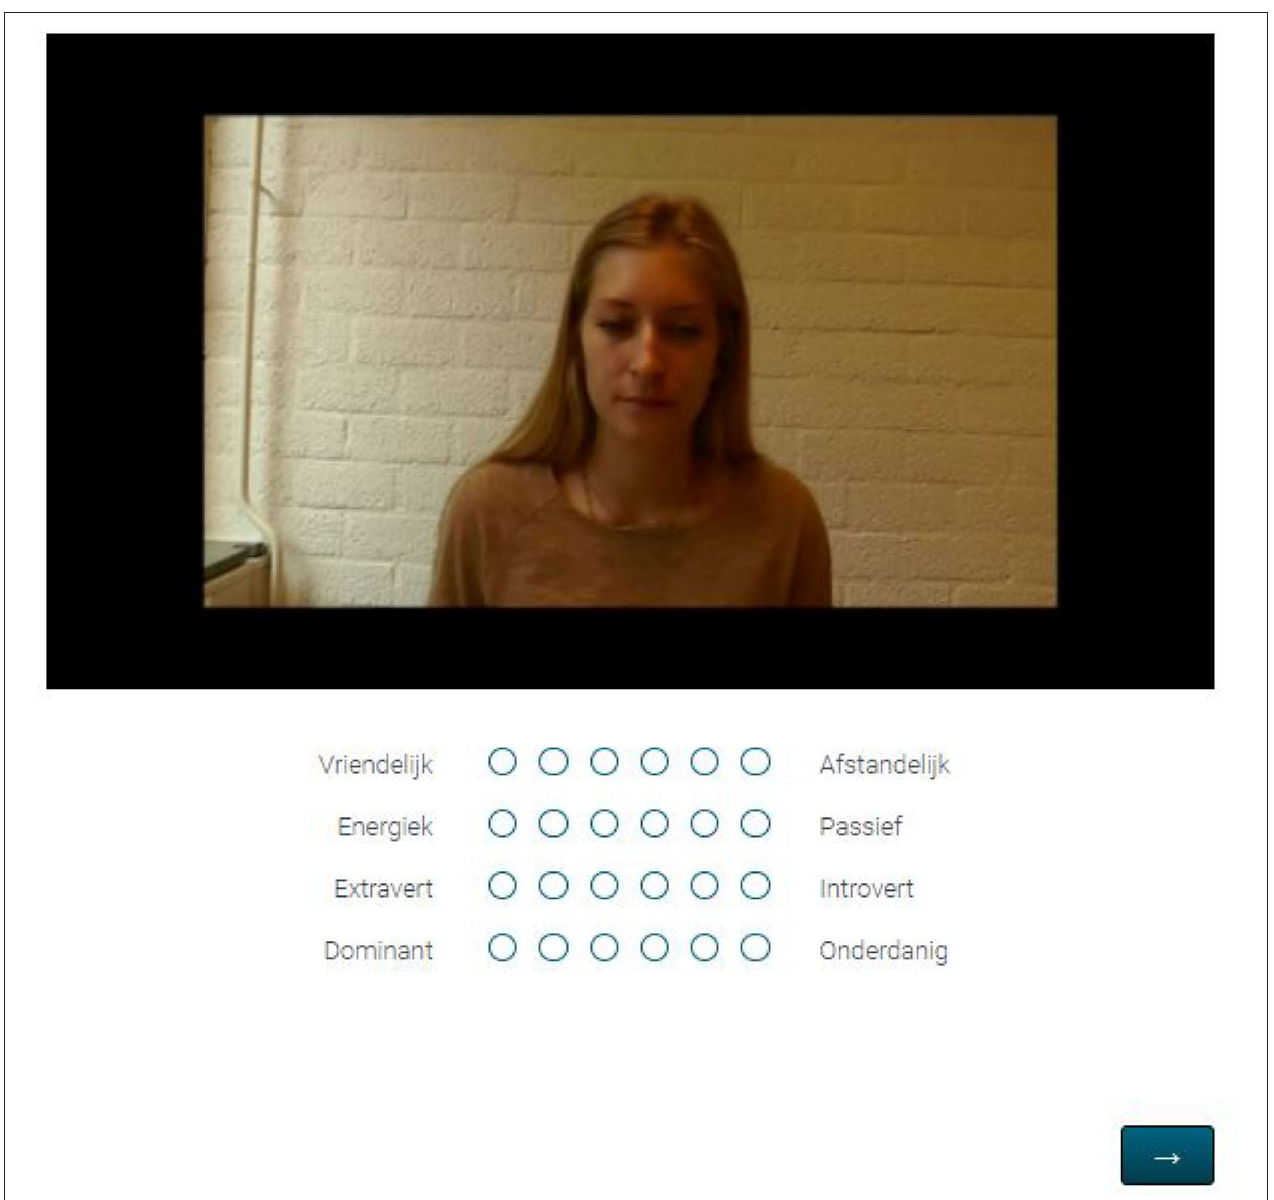
FIGURE 2 | Impression of a neutral picture question as part of experiment